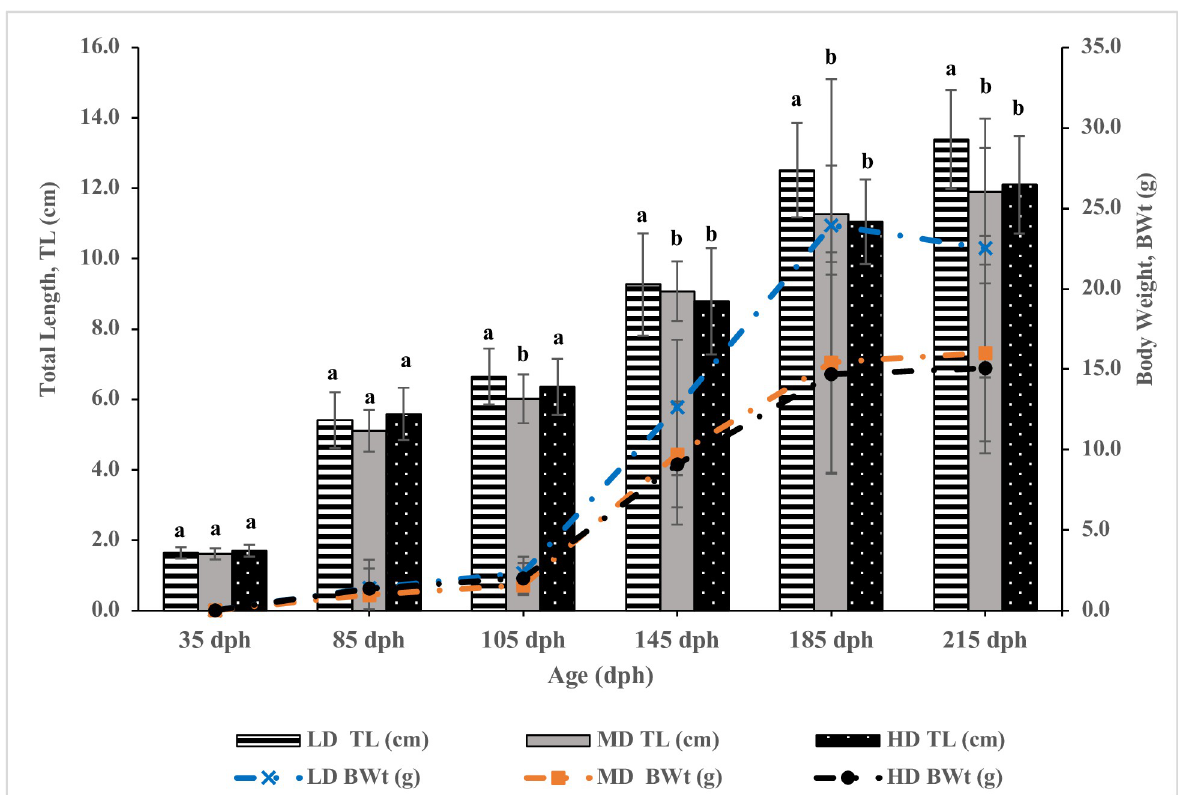
Fig 3. The final total length (cm) and body weight (g) of yellow perch reared at different stocking densities, measured from the beginning at the age of 35 dph until the end of experiment at the age of 215 dph. The data represent the mean ± SD. The mean values within the same column with different superscripts are significantly different ( P < 0 . 05 ).